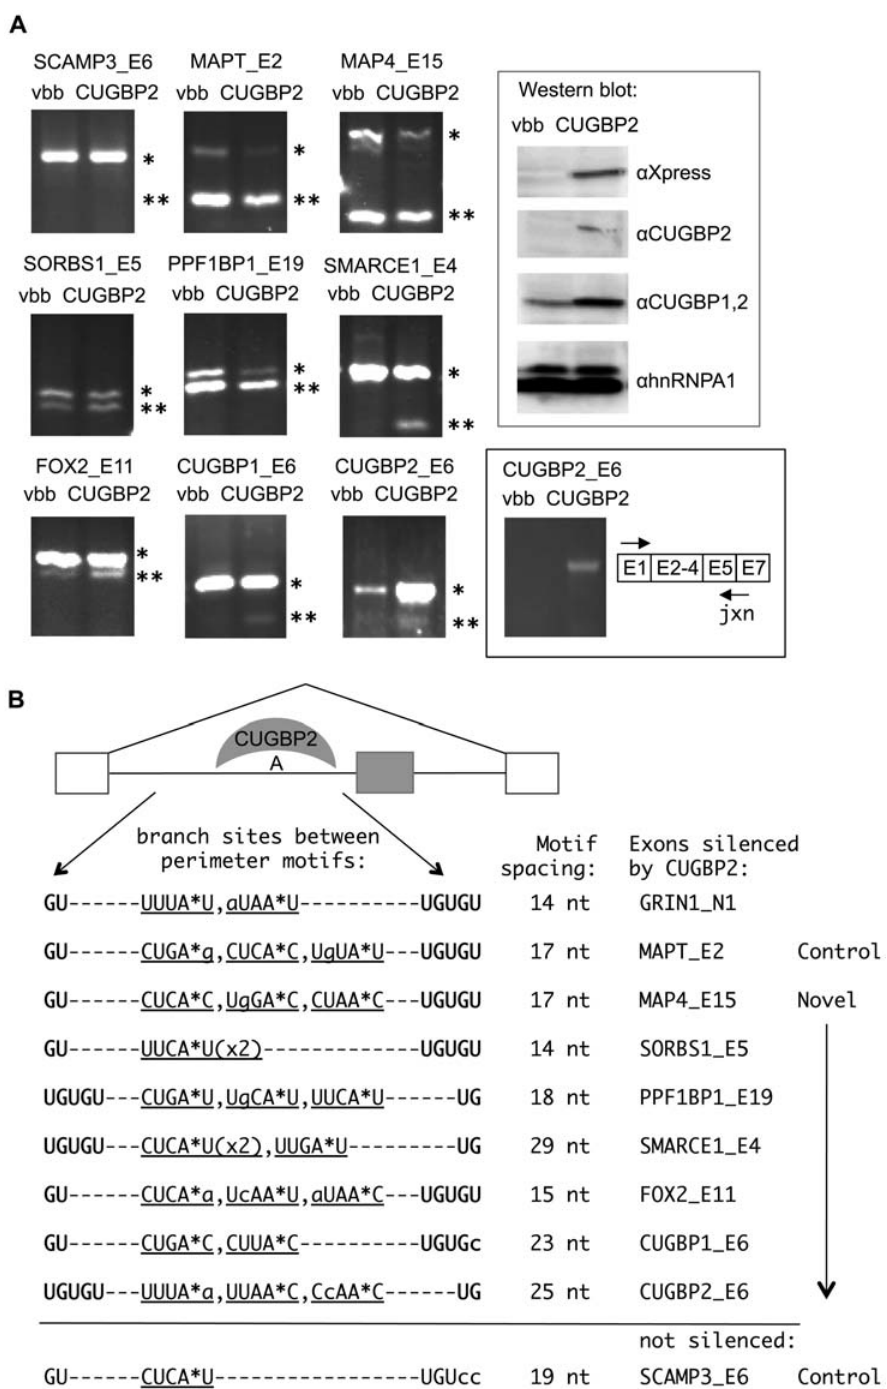
Figure 5. A motif code for splicing silencing reveals novel endogenous exons that are silenced by CUGBP2. (A) HEK293T cells were transfected for 36 hours with CUGBP2 protein expression vector (CUGBP2) or vector backbone control (vbb). Exon-included (*) and skipped (**) RT- PCR products are shown after separation on 2% agarose gels. The gene name and exon number are labeled above each panel. The D EI values are as follows: SCAMP3_E6, 0 6 0; MAPT_E2, 2 5.3 6 0.6; MAP4_E15, 2 11.7 6 3.5; SORBS1_E5, 2 8 6 1.7; PPF1BP1_E19, 2 12.3 6 2.1; SMARCE1_E4, 2 21.7 6 5.5; FOX2_E11, 2 10 6 2; CUGBP1_E6, 2 4.7 6 0.6; CUGBP2_E6, not determined; 6 , standard deviation of three separate experiments. Inset: Western blot confirming CUGBP2 expression ( a Xpress); total CUGBP2 as detected by 1H2 antibody ( a CUGBP2), CUGBP1 and 2 using 3B1 antibody ( a CUGBP1,2), and loading control ( a hnRNPA1). Black box: RT-PCR detection of CUGBP2 exon 6 skipped mRNA using primers specific for exon 1 and the exon 5/7 junction (jxn). (B) Model depicting the inhibition of branchpoint formation by the binding of CUGBP2 to flanking interaction sites. Below schematic: for exons silenced by CUGBP2, the predicted branch sites between the motifs are shown. Branchpoint adenosine (A*); lowercase letters indicate mismatches to the branch site consensus. Spacing in nucleotides (nt) between the perimeter motifs is shown for all tested